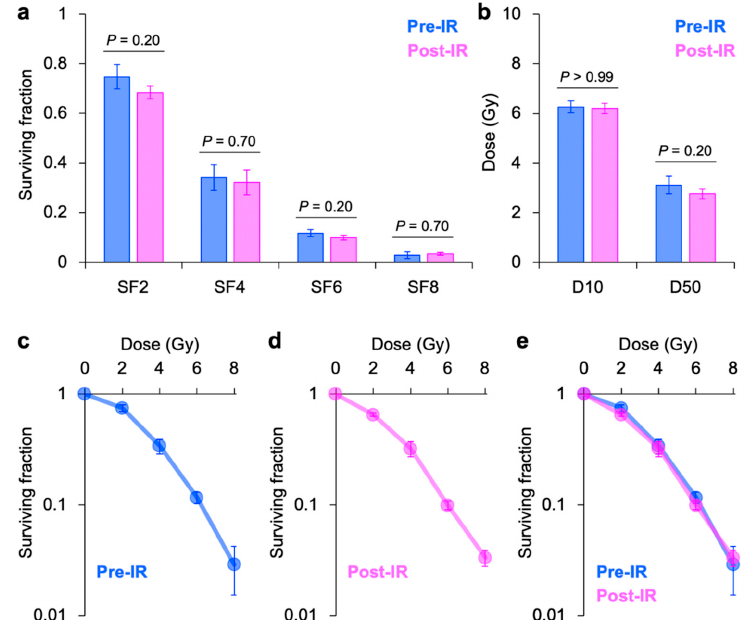
Figure 1. Clonogenic survival of X-ray-irradiated A549 cells assessed using plating methods in which cells are plated before (pre-IR) or after (post-IR) irradiation. ( a ) SF 2 , SF 4 , SF 6 , and SF 8 . ( b ) D 10 and D 50 . p -values were determined using the Mann–Whitney U-test. ( c ) Survival plots from pre-IR-plated cells. ( d ) Survival plots from post-IR-plated cells. ( e ) Survival plots from pre-IR (blue) or post-IR (violet) plating methods. Graphs are presented in 50% translucent colors; therefore, purple color indicates an overlap between the two plating methods. SFx indicates the survival at X Gy; Dx indicates the dose providing X% survival. Error bars indicate standard deviation. J. Pers. Med. 2020 , 10 , x FOR PEER REVIEW